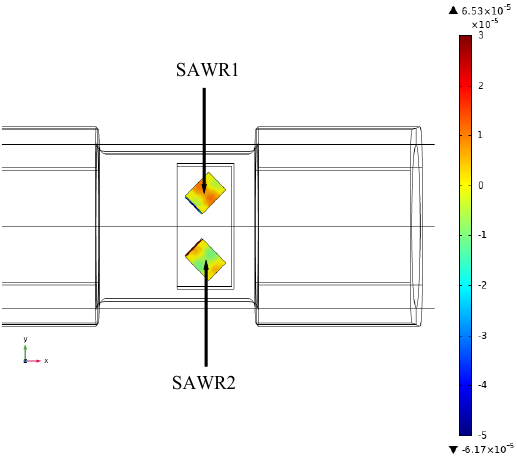
Figure 12. SAWR shape variable cloud.